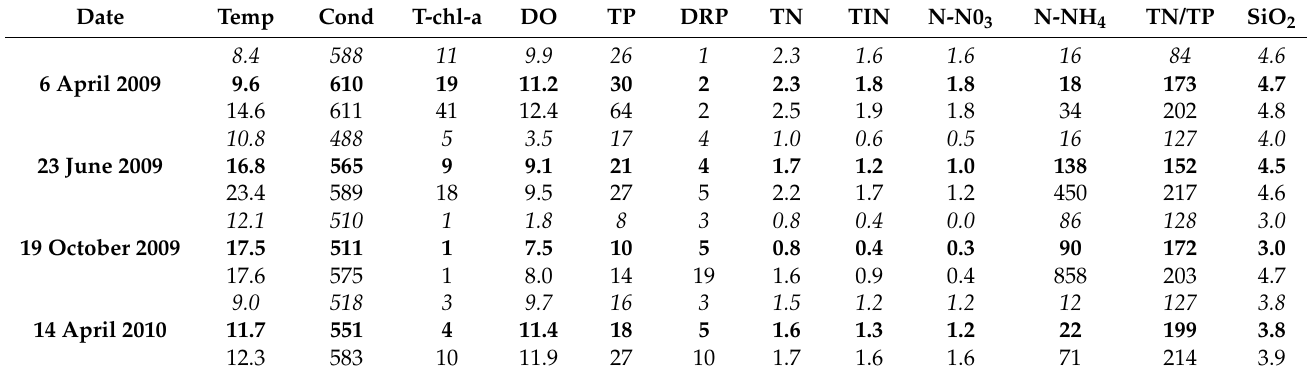
Table 3. Statistics of the relevant limnological variables collected at station St6 during the four field campaigns reporting minimum (italic), median (bold), and maximum (normal) values. Temp = temperature ( ◦ C), Cond = electrical conductivity ( µ S cm − 1 20 ◦ C), DO = dissolved oxygen (mg L − 1 ), T-chl-a = total chlorophyll-a ( µ g L − 1 ), N-NH 4 = ammonium ( µ g N L − 1 ), N-NO 3 = nitrate (mg N L − 1 ), TN = total nitrogen (mg N L − 1 ), DRP = dissolved reactive phosphorus ( µ g P L − 1 ), TP = total phosphorus ( µ g P L − 1 ), SiO 2 = silica (mg L − 1 ). 6 April 2009: N = 5, Dr = 0.5–30 m; 23 June 2009: N = 6, Dr = 0.5–30 m; 19